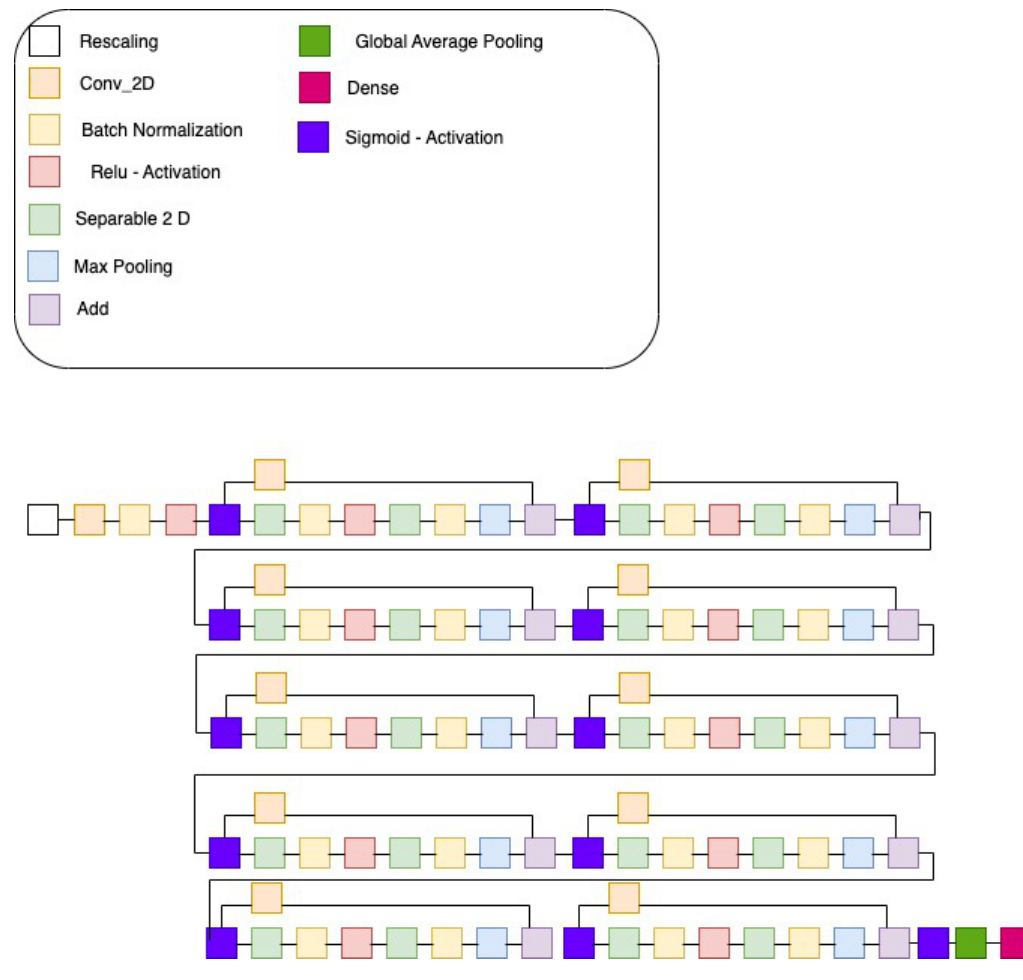
Figure 3. Structure of our proposal of CNN to detect LSB Steganography. Data enrichment (conversion to gray, rotating and resizing the images) was also applied after the generation of the infected images, but as additional noise was introduced in the identification of the stego images, detection became impossible (accuracy of 0.561) (see Figure 4) and this approach was discarded. After testing all possible combinations in the dataset that could have an impact on accuracy and overfitting, a model with an accuracy of 95.21% (see Figure 5) was obtained. Then, the model was improved with other possible steganography algorithms (random LSB Algorithms (LSB with Fibonacci and Fermat generators and F5), and, after the training, a validation accuracy of 98.61% was obtained (see Figure 6). The experimental setup is described in Section